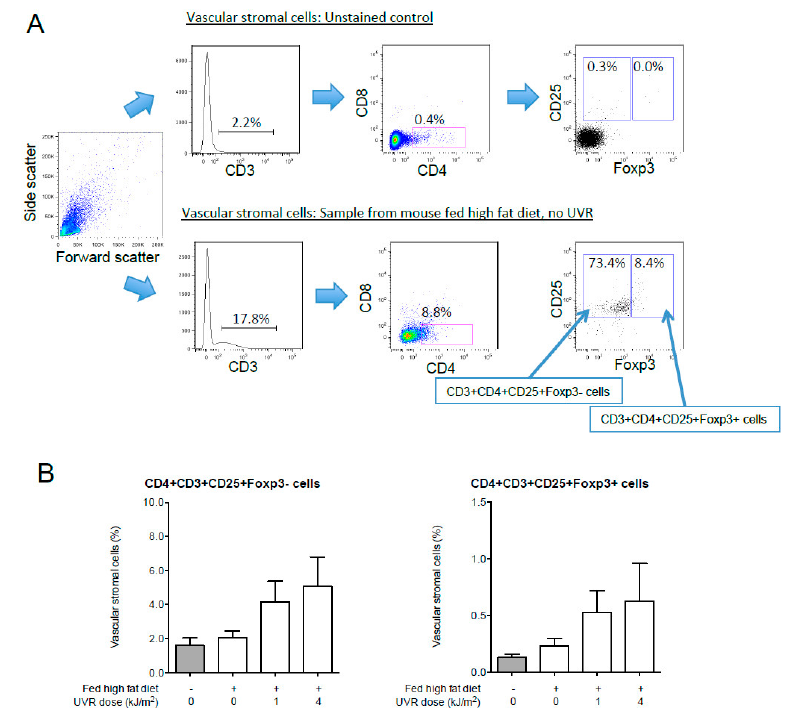
Figure 5. UVR may increase proportions of CD4+ T cells in WAT. Tissue was sampled from C57BL/6J male mice fed a low or high fat diet for 12 weeks. Some mice were exposed to 1 kJ/m 2 UVR (sub-oedemal dose, two times a week) or 4 kJ/m 2 UVR (oedemal dose, once a fortnight) for this 12-week period. The mice were from experiments described in [75]. Vascular stromal cells were isolated from gonadal WAT following digestion with collagenase IV (see [139]). Cells (10 6 ) were incubated with CD3-FITC, CD25-APC, CD4-PE-Cy5, Foxp3-APC and CD8-APC-Cy7 using previously described methods [139], and then acquired on a LSRII flow cytometer (BD Biosystems). ( A ) The gating strategy, with an example of the forward and side scatter of vascular stromal cells shown in the far left panel, with CD3 + and then CD4 + CD8 − cells selected, and cells then divided into CD25 + Foxp3 − and CD25 + Foxp3 + populations. Examples are shown of an unstained control sample, and a sample from a mouse fed the high fat diet and not exposed to UVR for 12 weeks; ( B ) Percentages of CD4 + CD3 + CD25 + Foxp3 − and Foxp3 + cells, calculated by multiplying the percentages of CD3 + , CD4 + CD8 − and CD25 + Foxp3 ± cells ( n = 6 mice/treatment, mean + SEM).